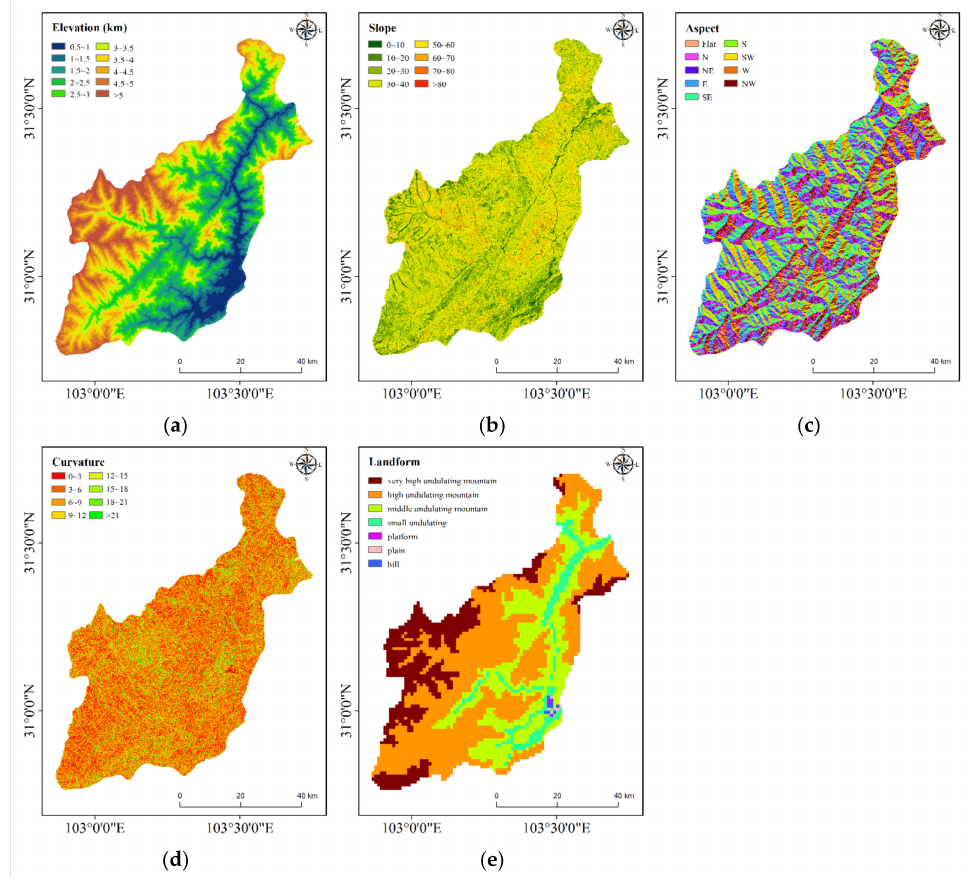
Figure 4. Terrain-related causative factors. ( a ) Elevation; ( b ) Slope; ( c ) Aspect; ( d ) Carvatu; ( e )